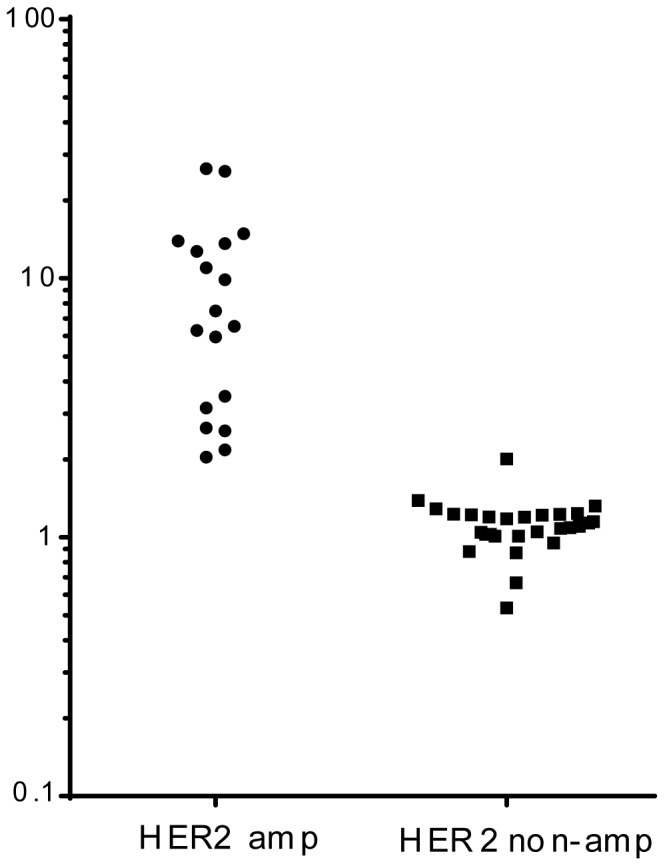

HER2:EFTUD2 digital PCR has high accuracy compared to conventionally defined HER2 status.
HER2:EFTUD2 ratio was assessed by digital PCR on DNA from 18 HER2 amplified and 58 HER2 non-amplified cancers demonstrating the narrow range of HER2:EFTUD2 ratios in non-amplified cancers.